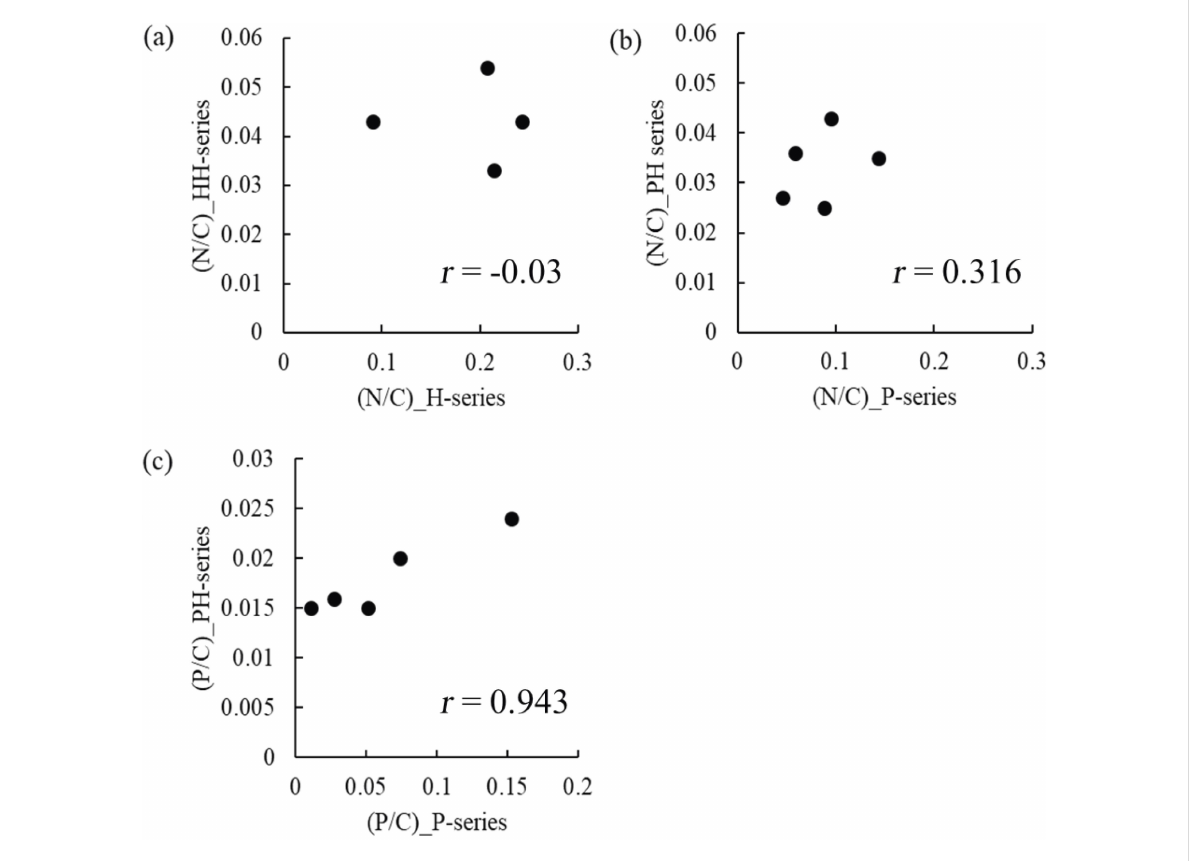
Figure 4: Correlations between (a) N/C ratios of HH-series carbon materials and those of H-series precursors, (b) N/C ratios of PH-series carbon ma- terials and those of P-series precursors, (c) P/C ratios of PH-series carbon materials and those of P-series precursors. The figures show the linear correlation coefficients, r , calculated from least mean-square analysis of the